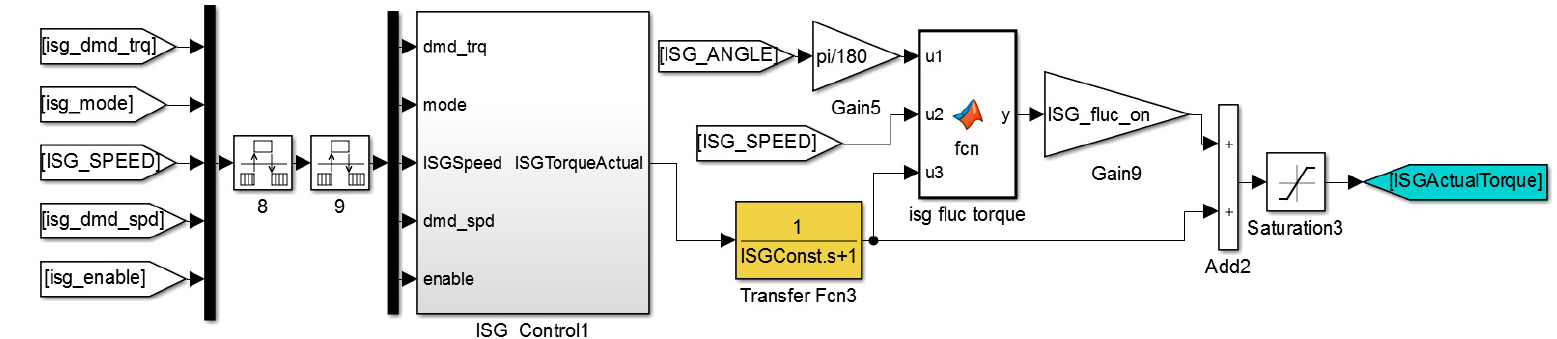
Figure A3. Active control module in Simulink.